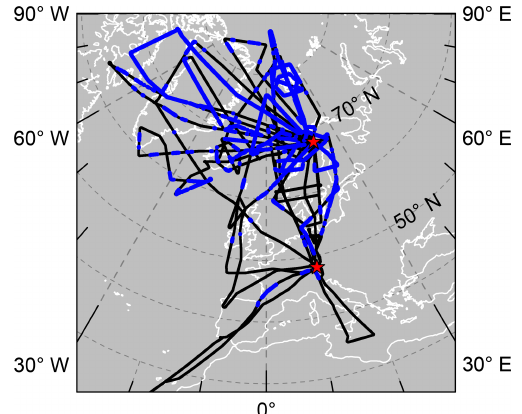
Figure 1. Map of flight tracks of the PGS science flights. Red stars mark the two bases of operation Oberpfaffenhofen (EDMO) at 48 ◦ N, 11 ◦ E and Kiruna (ESNQ) at 68 ◦ N, 20 ◦ E. Flight sections where polar vortex air was encountered according to the criterion from Sect. 2.4.1 are indicated in